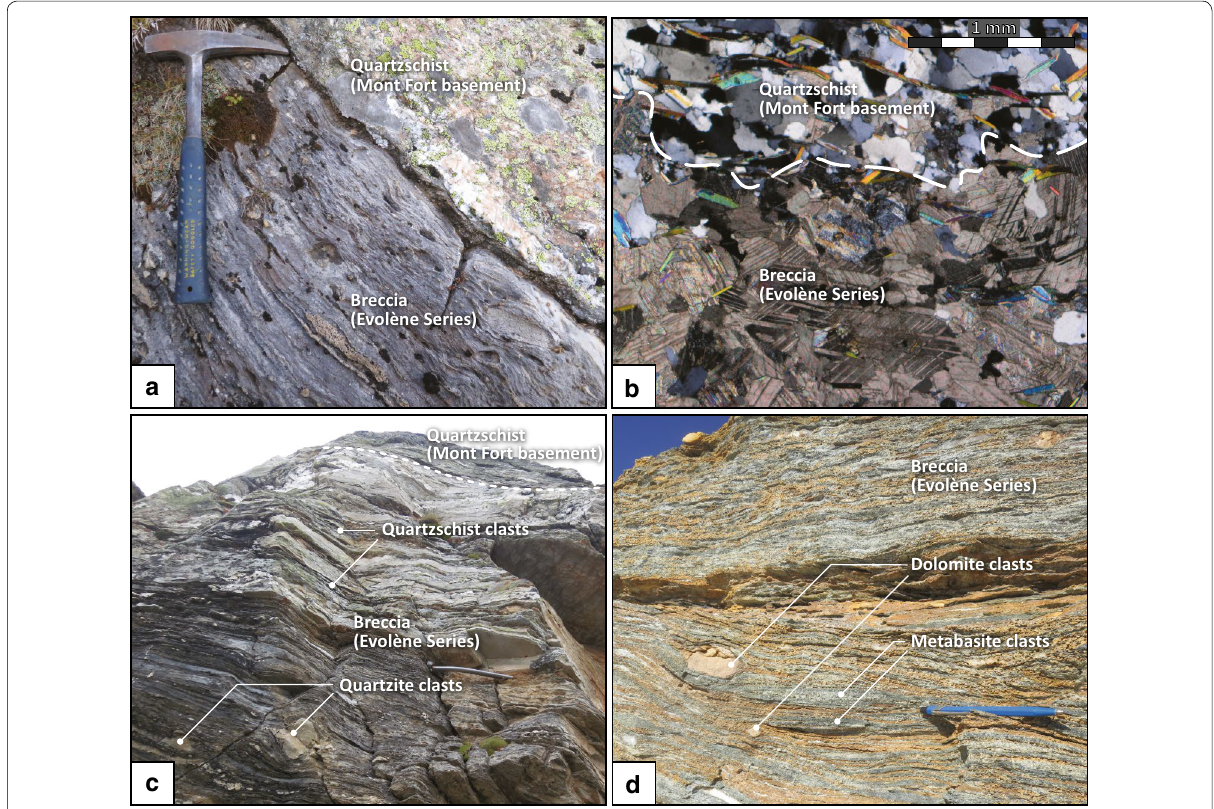
Fig. 12 Contacts between the Evolène Series Jurassic breccias and the Mont Fort Paleozoic basement. a Overturned contact between the Evolène U. Jurassic polymict breccia and the Mont Fort Permian quartzschists [598 ′ 730/106 ′ 890]. Note the absence of mylonitic levels or abnormal rock deformation at contact. Location on Fig. 9a. b Same type of contact, observed in thin‑section (cross‑polarized light), [599 ′ 440/105 ′ 890]. No abnormal deformation is observed even at the grain scale. Location on Fig. 9a. c Overturned contact between the Evolène U. Jurassic polymict breccia and the Mont Fort Permian quartzschists [600 ′ 010/106 ′ 750]. Within the first 3 m from the contact, the breccia is very rich in quartzschist clasts (reconstituted basement). Location on Fig. 9b. d Evolène U. Jurassic polymict breccia showing an abundance of metabasite clasts [594 ′ 470/098 ′ 040]. The clast lithology is identical to that of the Mont Fort metabasites (Métailler Fm.) which are outcropping less than 10 m away. Location on Fig. 6